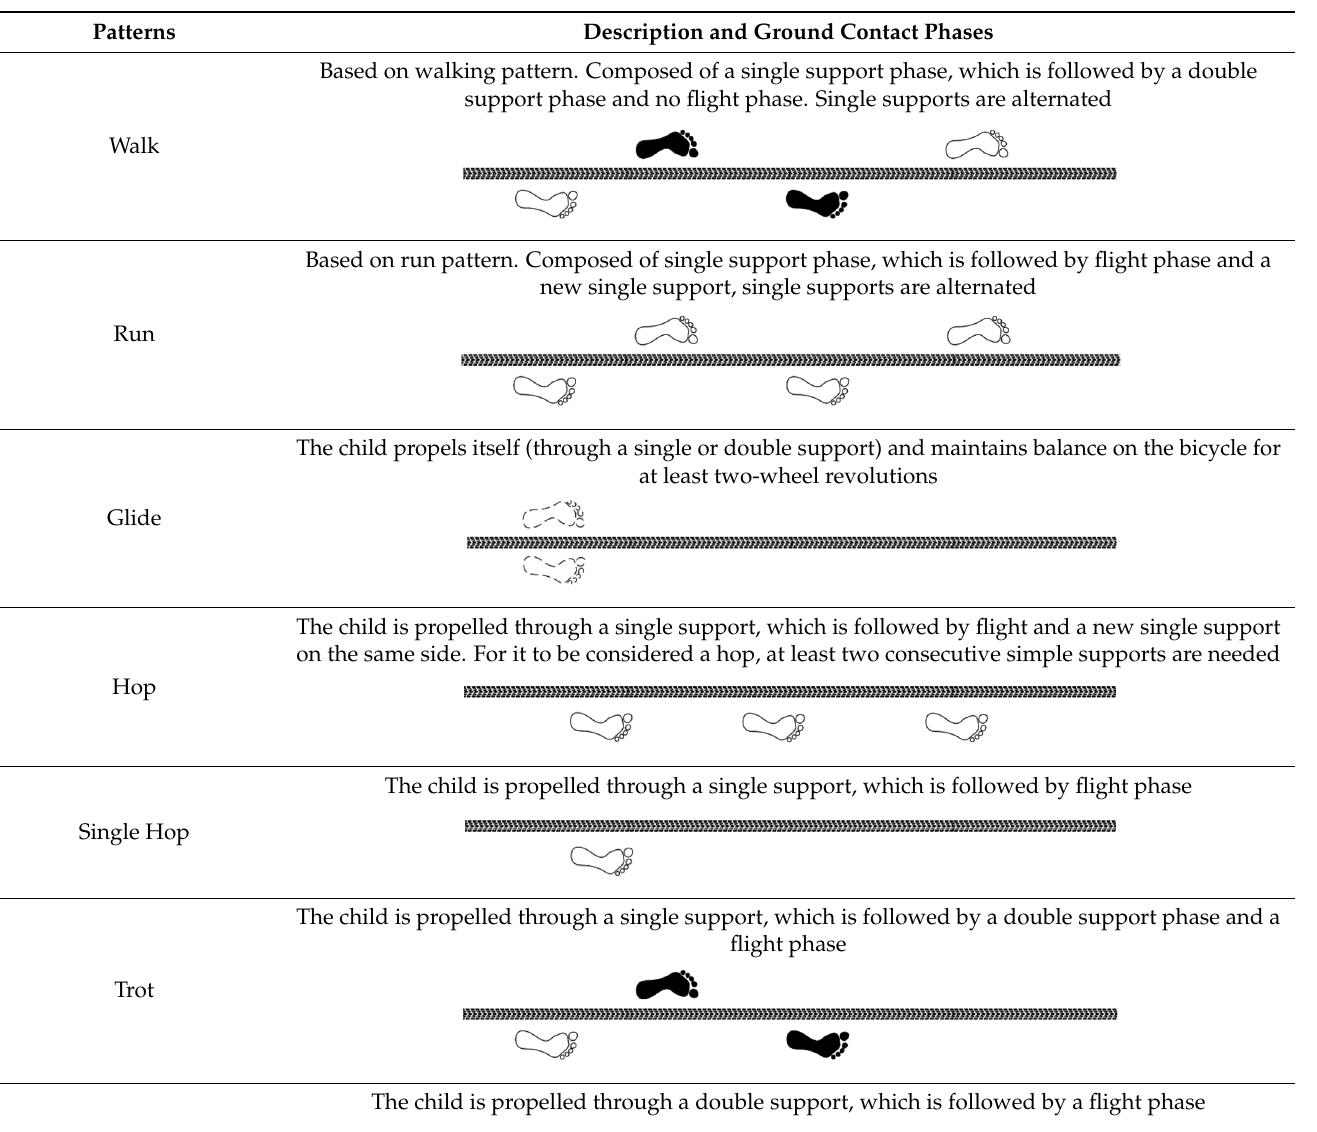
Table 1. Categorization of cycle patterns on BB based on ground contact phases description.